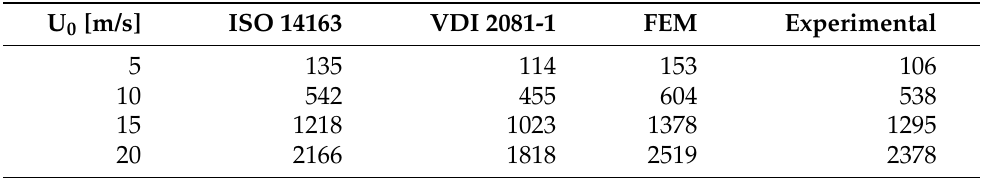
Table 3. Pressure loss (in Pascals) obtained with ISO 14163, VDI 2081-1, FEM and experimental measurements for the system of splitters with rectangular profiles.